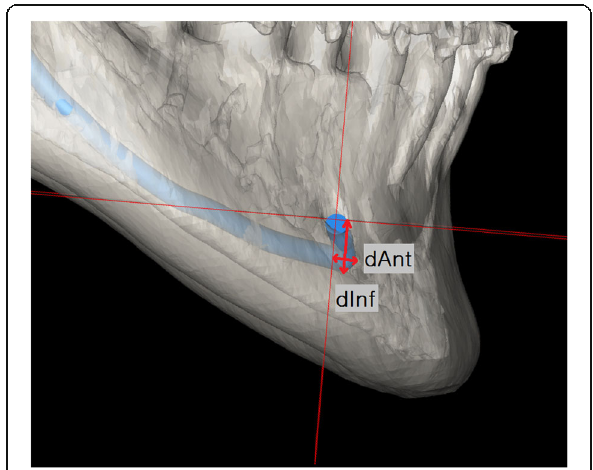
Fig. 3 Measurement of dAnt and dInf. dAnt, distance from the most anterior point of the inferior alveolar nerve from MF_V. If there is no anterior curvature, dAnt is defined as “ 0 ” ; dInf, distance from the most inferior point of the inferior alveolar nerve from MF_H